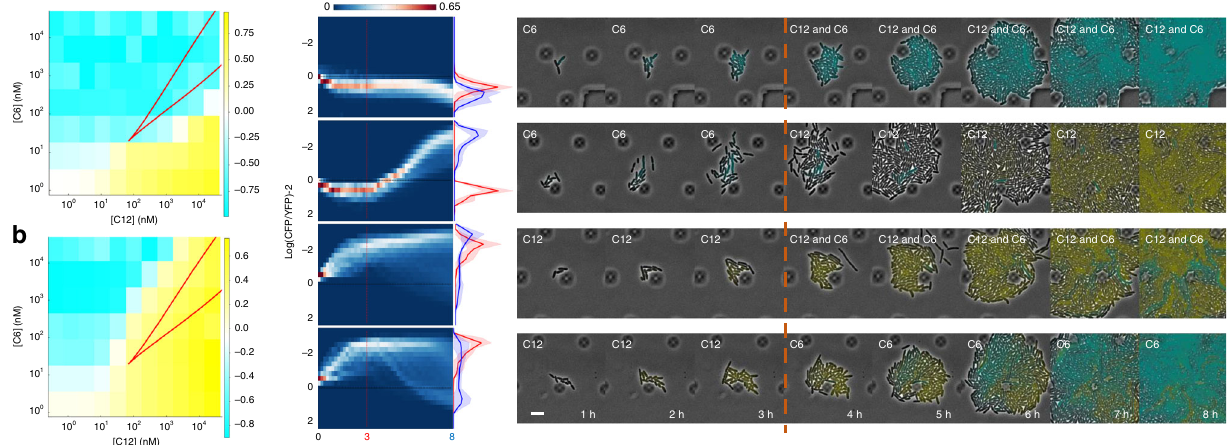
Fig. 2 Mutual inhibition produces bistability. Cells transformed with the Exclusive Receiver circuit were conditioned in either 500 nM C6 ( a ), or 500 nM C12 ( b ), and then exposed to the combinations of concentrations of C6 and C12 indicated. Cells were measured using fl ow cytometry and their normalized CFP minus YFP expressions were plotted. The region of bistability predicted by the parameterized model is the area within the red lines. See Supplementary Fig. 3 for gating strategy for all fl ow cytometry and Supplementary Fig. 13 for replicates. Source data are provided as a Source Data fi le. c Micro fl uidics cultures of cells transformed with Exclusive Receiver circuit in changing combinations of signals. Cells were grown for 3 h in the presence of either 37 nM C6 (rows 1 and 2) or 100 nM C12 (rows 3 and 4). Then media was changed to 100 nM C12 + 37 nM C6 (rows 1 and 3) or 100 nM C12 (row 2) or 37 nM C6 (row 4) . Cells were imaged with a frame rate of (1 frame/10 min). Left panels are kymographs of the log-ratio of CFP expression per-cell to YFP expression per-cell, and fraction of cells as a heat map. Histograms represent the populations at 3 h (red) and 8 h (blue). Lines and shaded region represent the mean and standard deviation, respectively, over n = 4 biological replicates performed on 4 different days. Right panels are sample montages of cells switching state (rows 2 and 4) or exhibiting bistablity (rows 1 and 3); phase contrast and fl uorescence channel ranges chosen for display. Scalebar = 6 μ